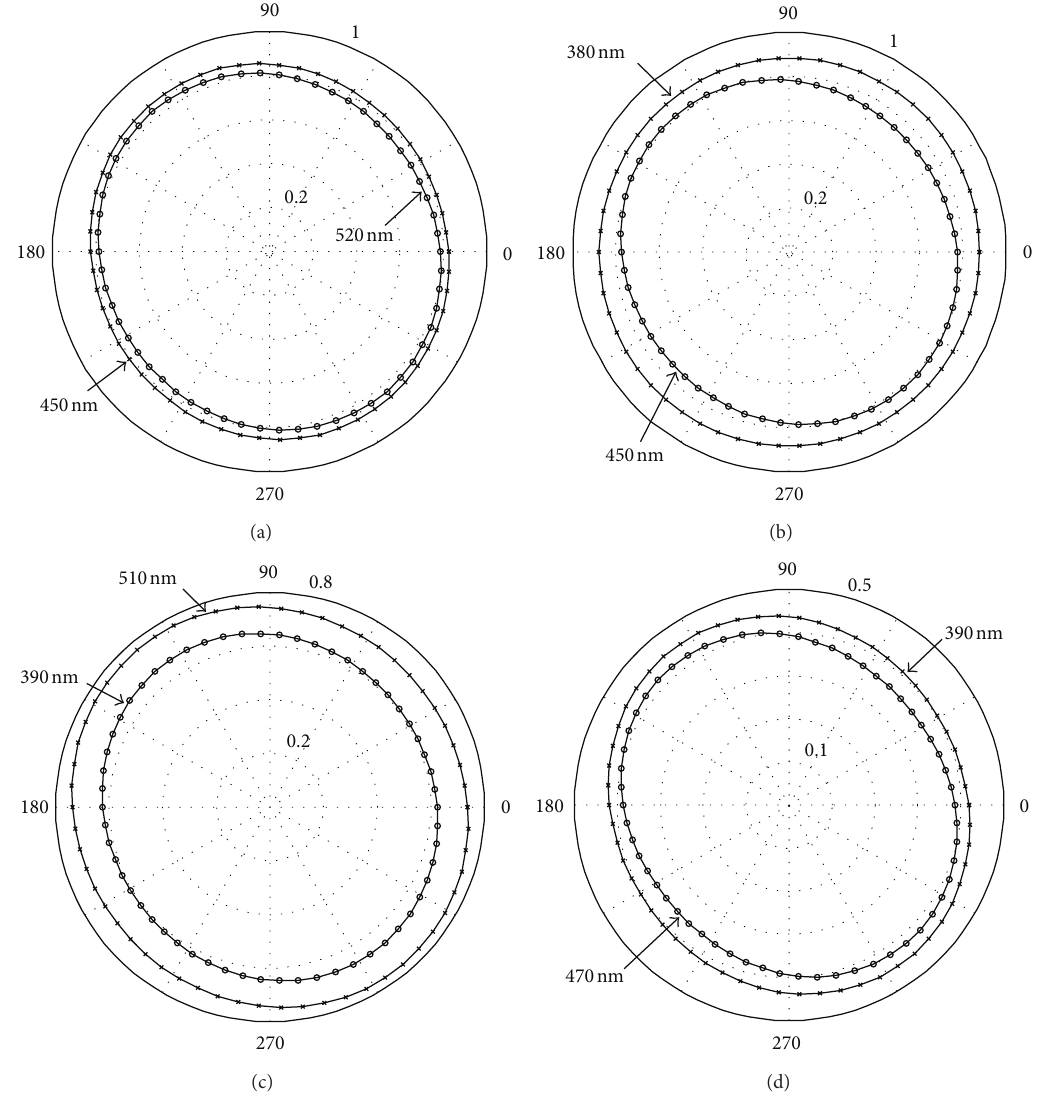
Figure 5: Polar plots of the (1 − 𝑅) spectra of Ag chiral pentagon thin film for TM and LM wavelengths obtained at two different incident angles (𝜃) . ((a) and (b)) 𝜃 = 10 ∘ , 𝑝 - and 𝑠 -polarizations, respectively; ((c) and (d)) 𝜃 = 70 ∘ , 𝑝 - and 𝑠 -polarizations,